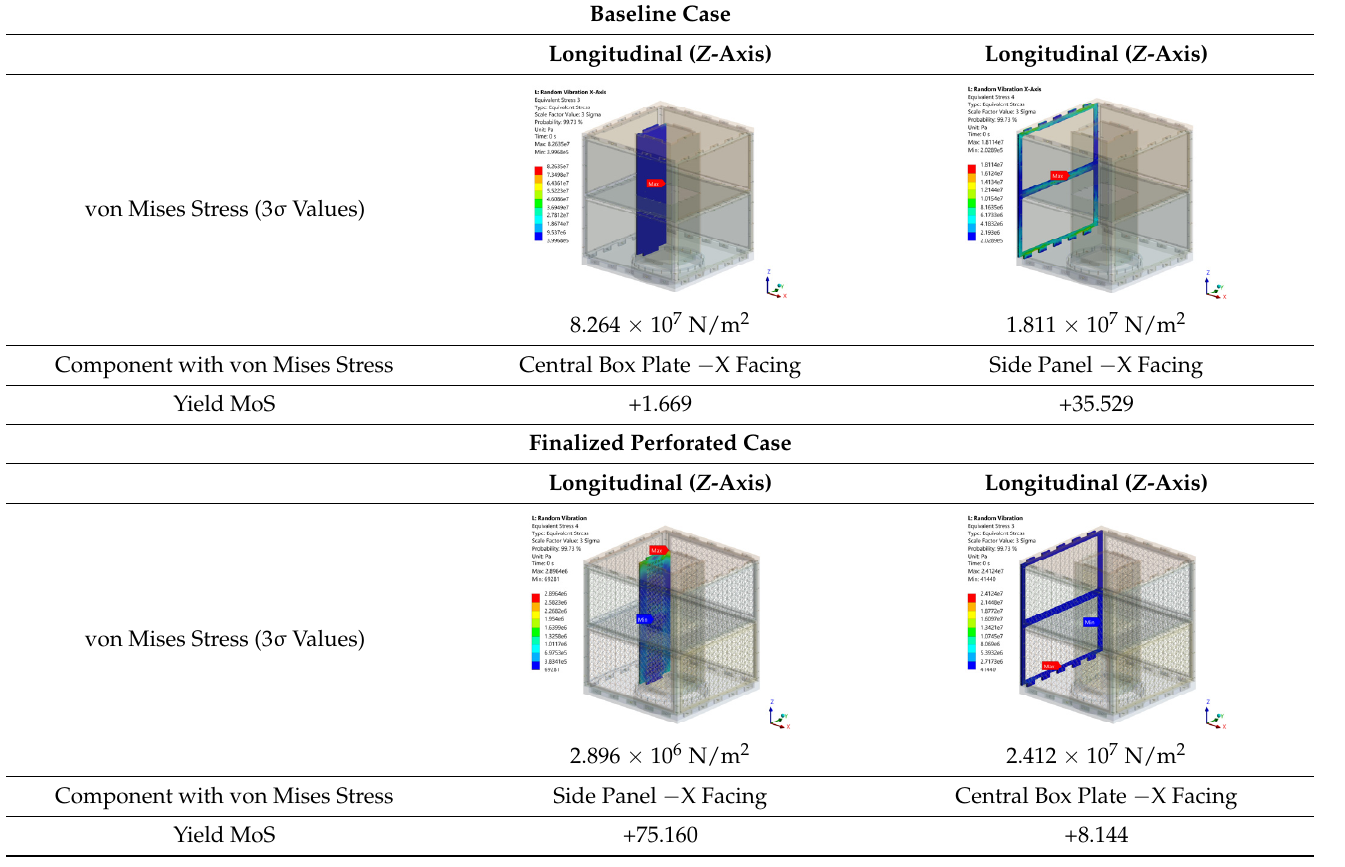
Table 7. Baseline and perforated random launch loads—von Mises stresses, longitudinal direction.